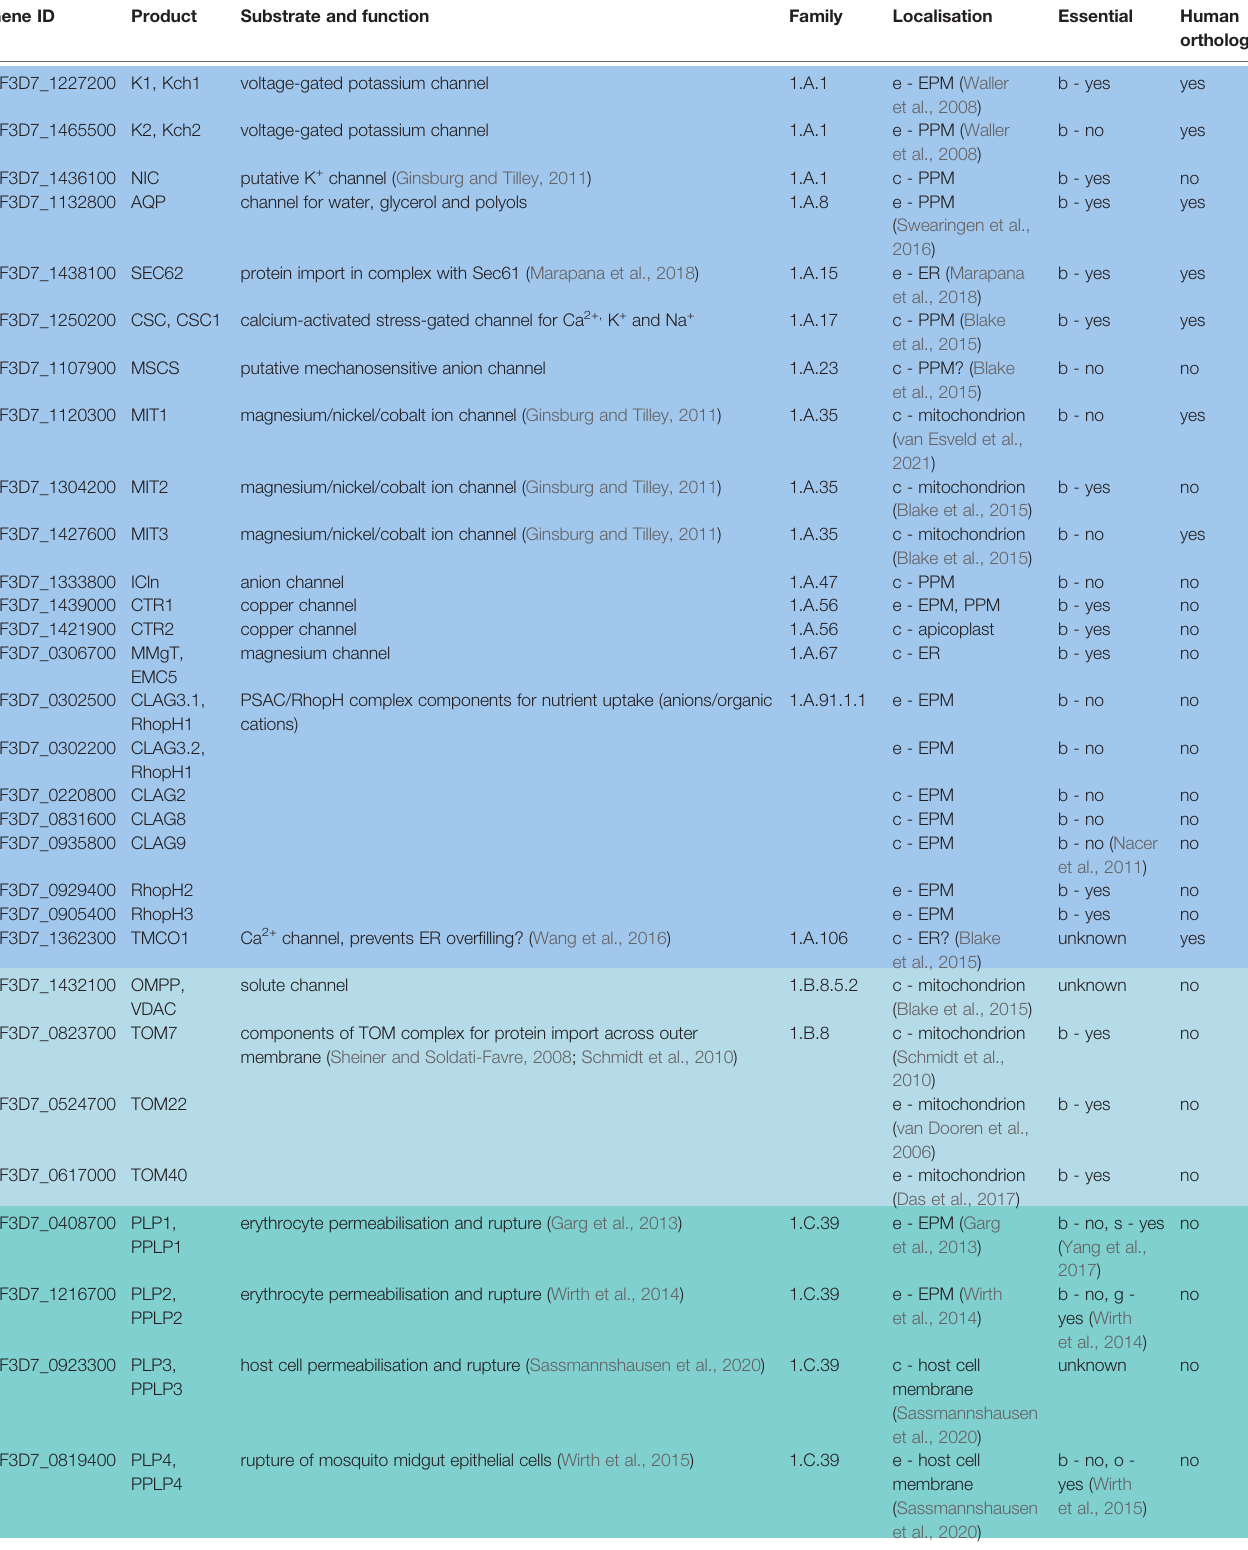
TABLE 1 | Characteristics of known and putative P. falciparum transport